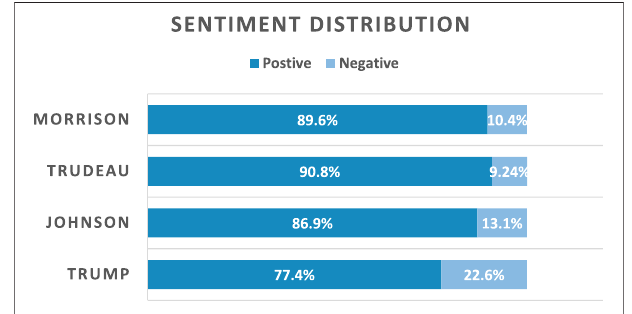
FIGURE 3 | Sentiment